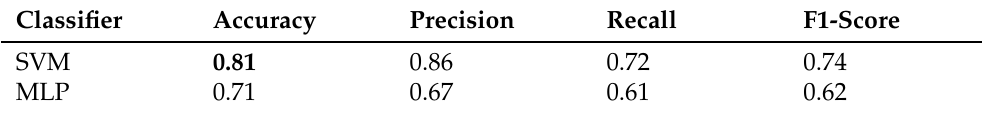
Table 4. ML Classifiers Performance.